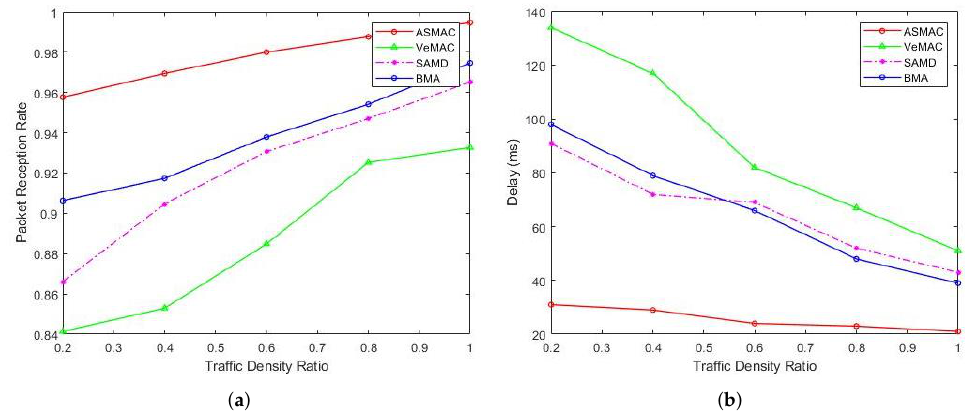
Figure 8. ( a ) Packet reception rate and ( b ) delay under different traffic density ratios when the number of vehicles is 200.